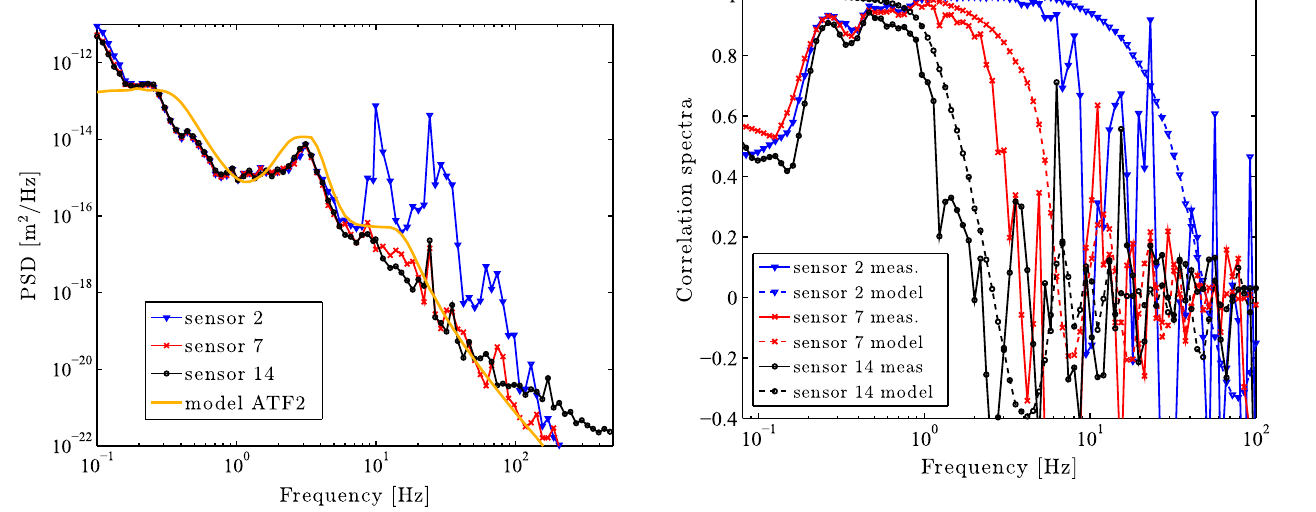
FIG. 9. Power spectral densities of the ground motion sensor measurements and model data in vertical direction.